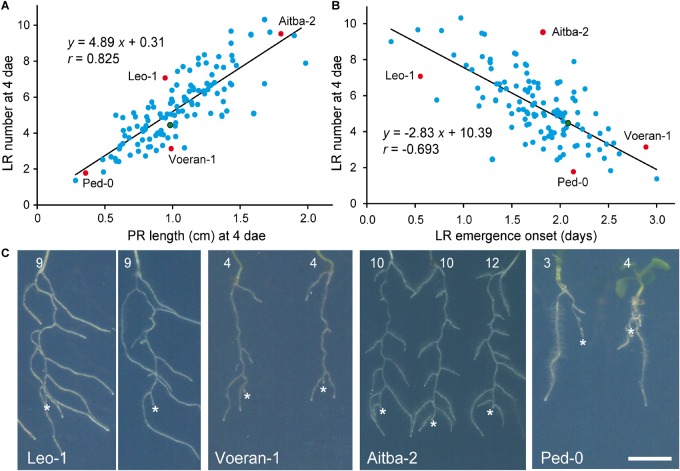
Phenotypic variation of LR architecture after root tip excision. (A,B) Scatter plots of average values for LR number and PR length, or LR number and LR emergence onset among the studied accessions. (C) Some accessions with extreme LR architecture phenotypes after root tip excision. Asterisk marks the PR tip after excision and numbers refer to LR number at 4 dae. Scale bar: 5 mm. Red dots indicate the accessions with contrasting phenotypes shown in (C) and green dots correspond to Col-0.